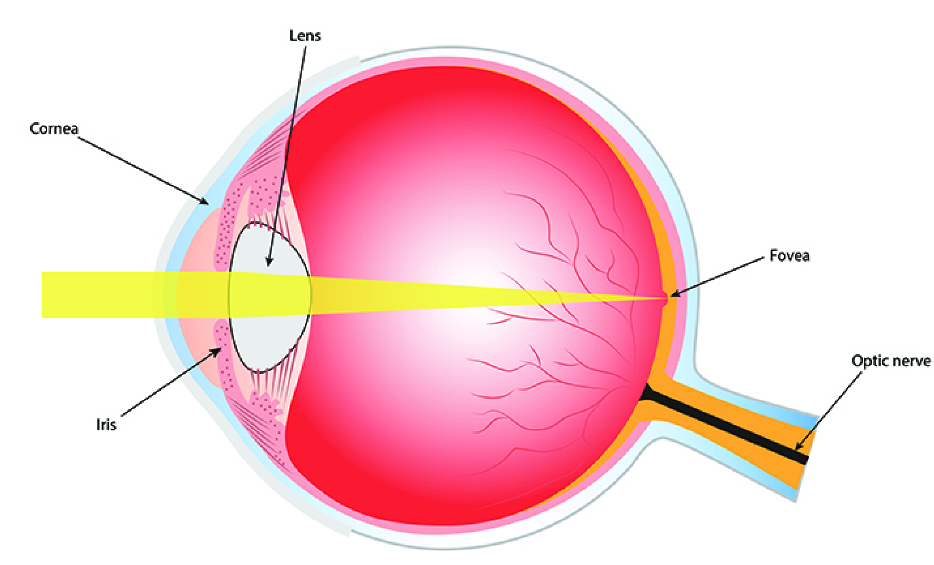
Figure 6. Eye, retina and fovea. Adapted from Wikipedia Magnification = distance between two points of V1 cortex which corresponds to 1 mm distance in retina. The cortical magnification in the fovea 1mm ∼ (1/6) ◦ = 0.05 mm is 20 times. The cortical magnification in the periphery 1 mm = 6 ◦ = 1.8 mm is 0.55